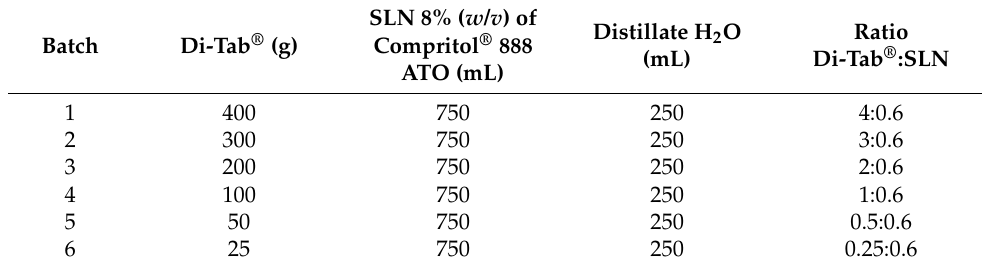
Table 6. Compritol ® 888 ATO SLN/ Di-Tab ® ratios for the co-processed excipients